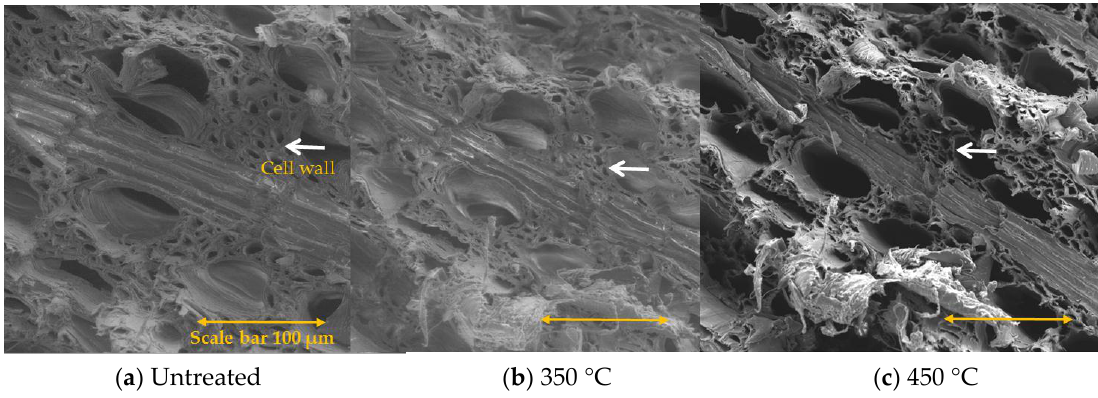
Figure 9. SEM images (horizontal field width = 320 μm; scale bar of 100 μm) of the cross section views of the untreated and the 350 and 450 °C treated cherry wood samples. White bars point out cell walls which were thinner after the thermal treatments.